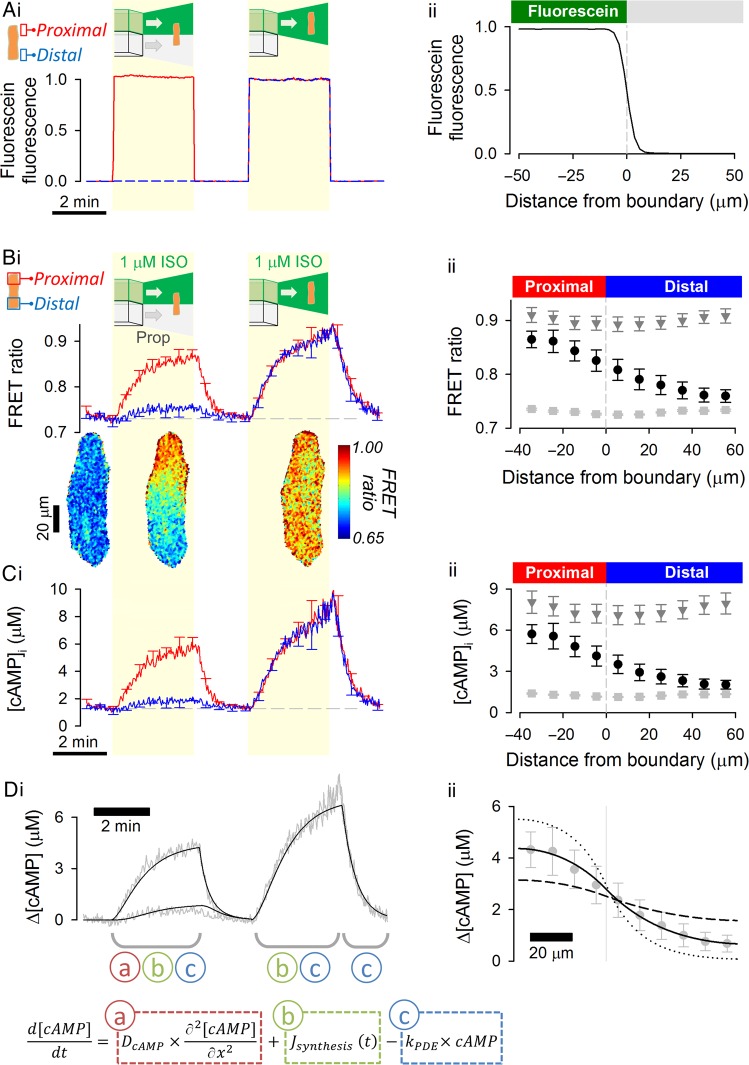
cAMP diffusivity measured using the H187 sensor is low in the cytoplasm of adult ventricular myocytes. (A) The experimental protocol is visualized with fluorescein added to one of two microstreams. (i) Time course of fluorescence emitted from extracellular fluorescein surrounding the proximal and distal regions of interest (ROI) of a myocyte. Manoeuvres 1 (both microstreams are released) and 2 (only fluorescein-containing microstream is released) are shaded yellow. (ii) Profile of fluorescence across the boundary between microstreams, showing the sharp (<10 µm) degree of microstream separation (n = 10/3). (B) Experiment on H187-expressing myocyte. 1 μM isoproterenol (ISO) included in one microstream (green) to active β-adrenoceptors; other microstream contained 10 µM propranolol, β-adrenoceptor antagonist (n = 11/4). (i) Time course of FRET ratio in proximal and distal ROIs; (ii) Longitudinal profile of FRET ratio, relative to boundary position, measured under resting conditions (light grey squares), during the last 10 s of Manoeuvre 1 (black circles) and during the last 10 s of Manoeuvre 2 (dark grey triangles). (C) Calibrated [cAMP] (i) time course and (ii) longitudinal profiles. (D) Mathematical model fit to experimental data. Best-fit DcAMP = 35 ± 3.4 µm2/s indicates slow cAMP diffusion inside adult cardiac cytoplasm. To illustrate the goodness-of-fit to data, longitudinal profiles were also simulated for a four-fold lower (dotted lines) and a four-fold higher (dashed lines) DcAMP. Inset: the partial differential equation describing cAMP dynamics is a linear combination of three processes (labelled a, b, and c). These can be parameterized sequentially by analysing different stages of the experiment. Dynamics in the third stage are determined by degradation only (c). With this information, it is then possible to characterize synthesis (b) by analysing the second stage. Having parameterized b and c, diffusion (a) can be obtained by analysing the first stage.